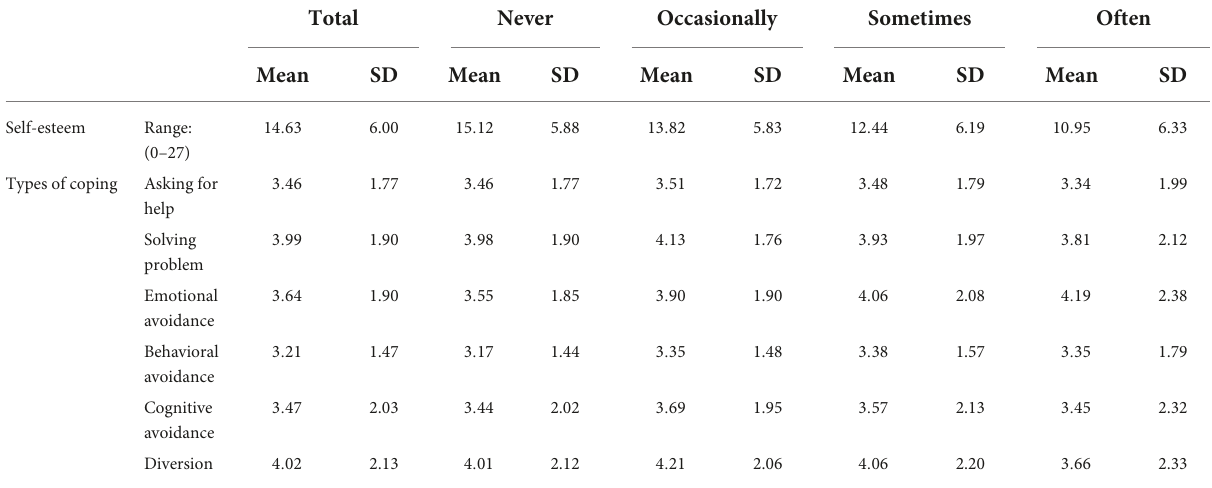
TABLE 2 Distributions of self-esteem and coping scores.